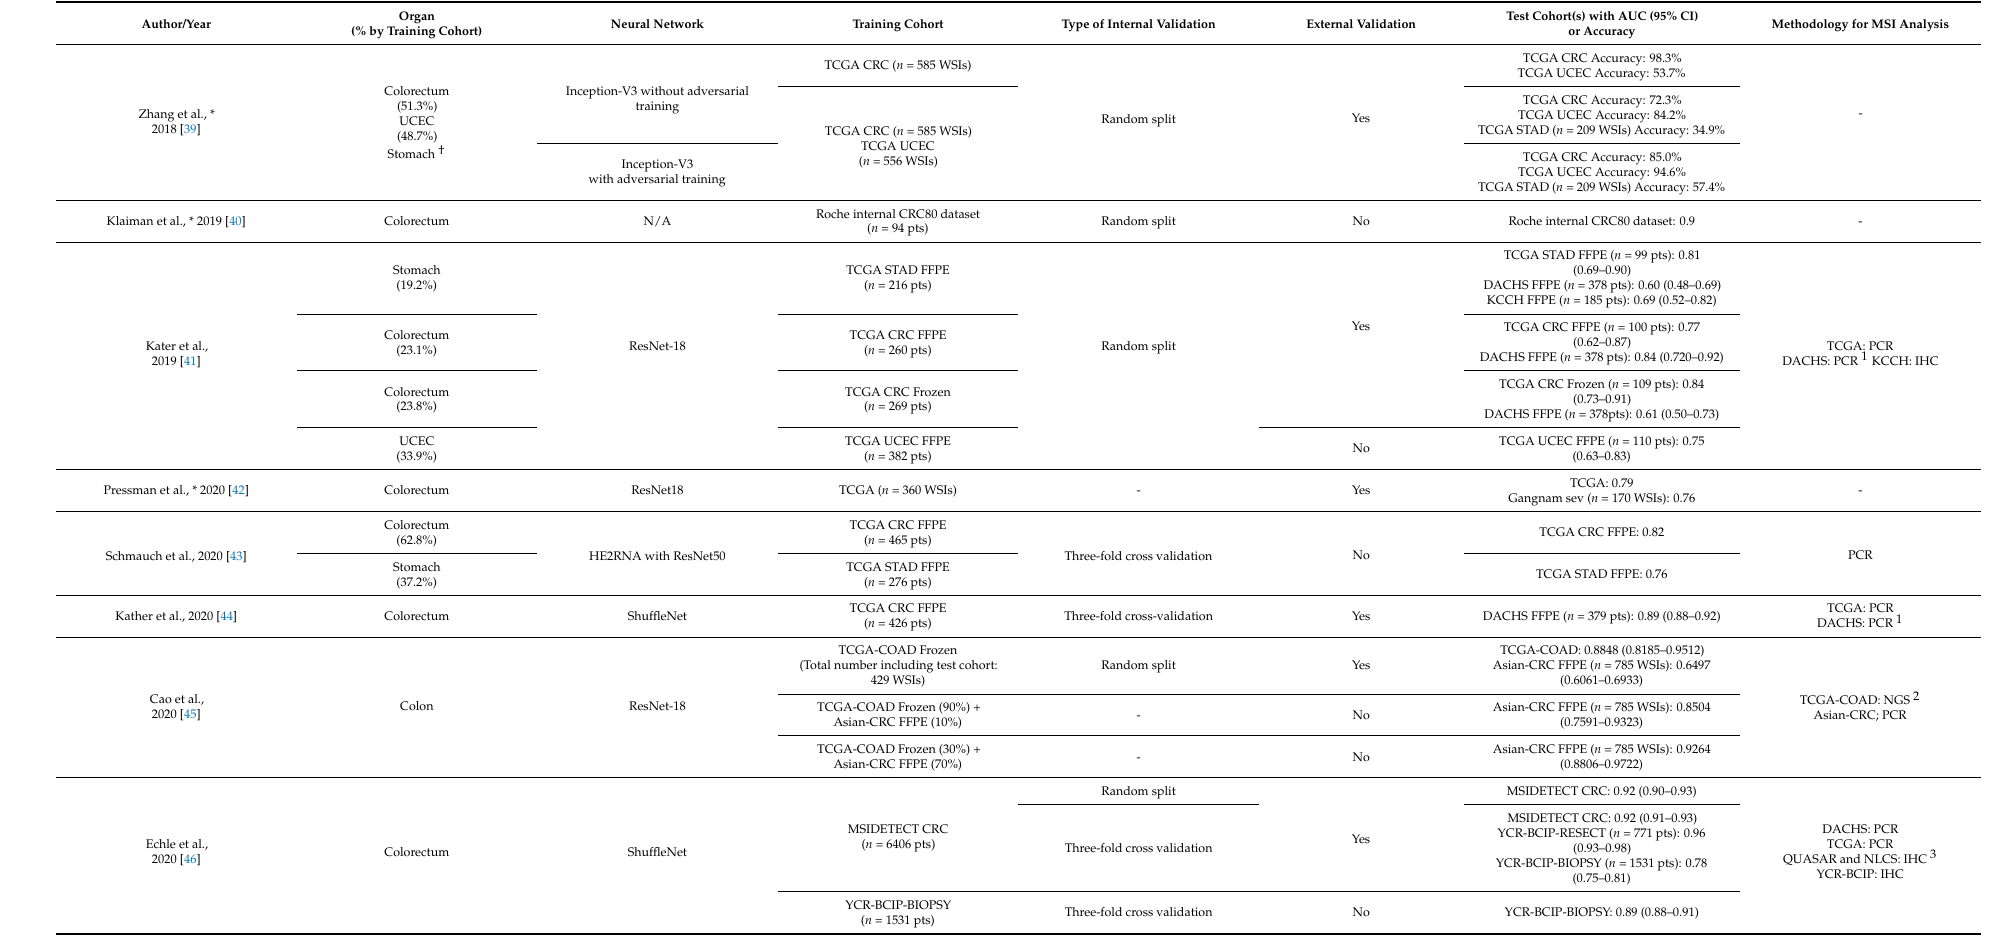
Table 1. Comparison of studies regarding detection of MSI/dMMR from histology slides using deep